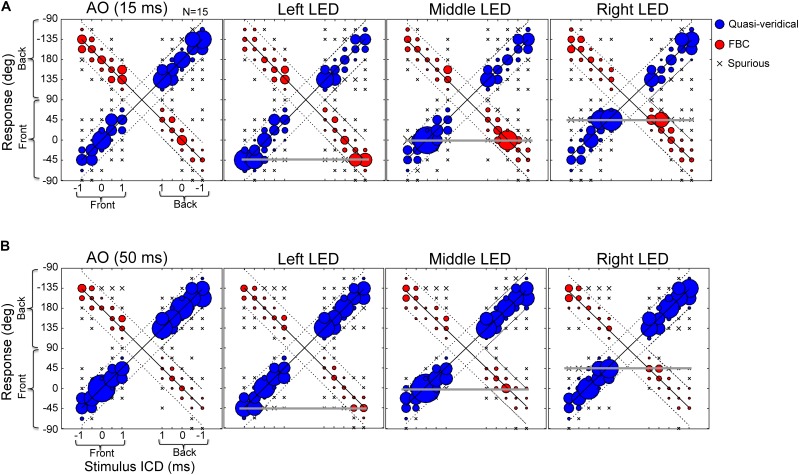
Effects of LED lights on stereo localization. (A) Results of 15-ms stimulus duration with and without lights. (B) Results of 50-ms stimulus duration with and without lights. The three response categories (quasi-veridical, front–back confused, and spurious) are similarly plotted as those in Figure 3. The stimulus-response layout on each panel is identical to those shown in Figure 3. Briefly, the left half of a panel shows front stimuli and the right half shows rear stimuli; the bottom half of a panel shows frontal response (–90 to 90°) and the top half shows rear response (91 to –91°). The three horizontal lines mark the locations of left, middle, and right LED lights (located at –45, 0, and 45°, respectively). Visual capture is manifested by an increased bobble size relative to AO results on each of the three horizontal lines.